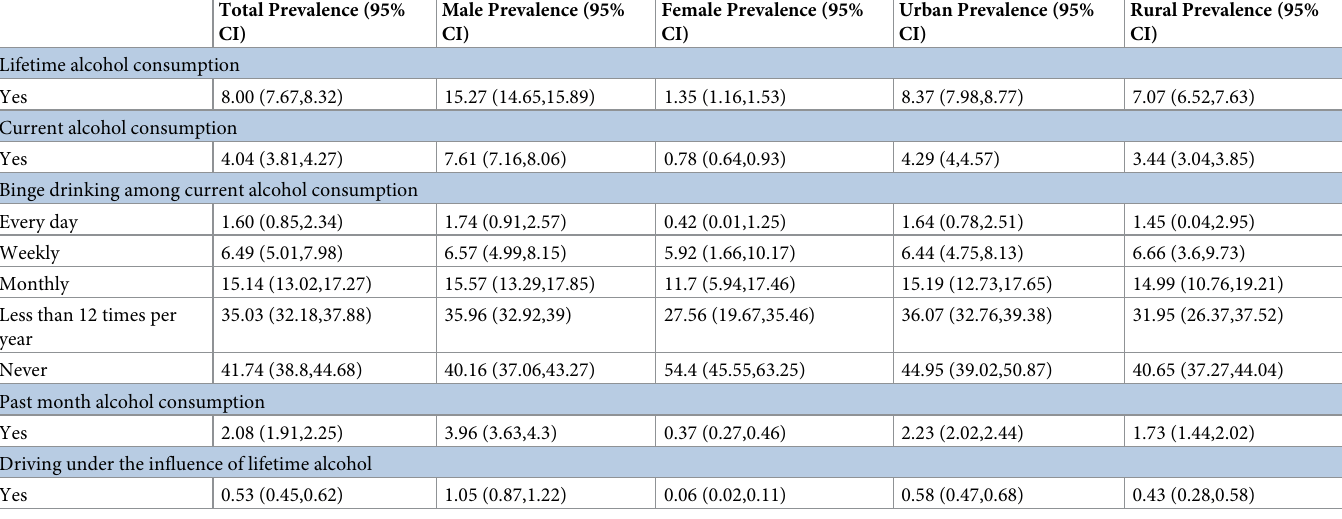
Table 2. Pattern of alcohol consumption in Iran in 2016 (National Level).